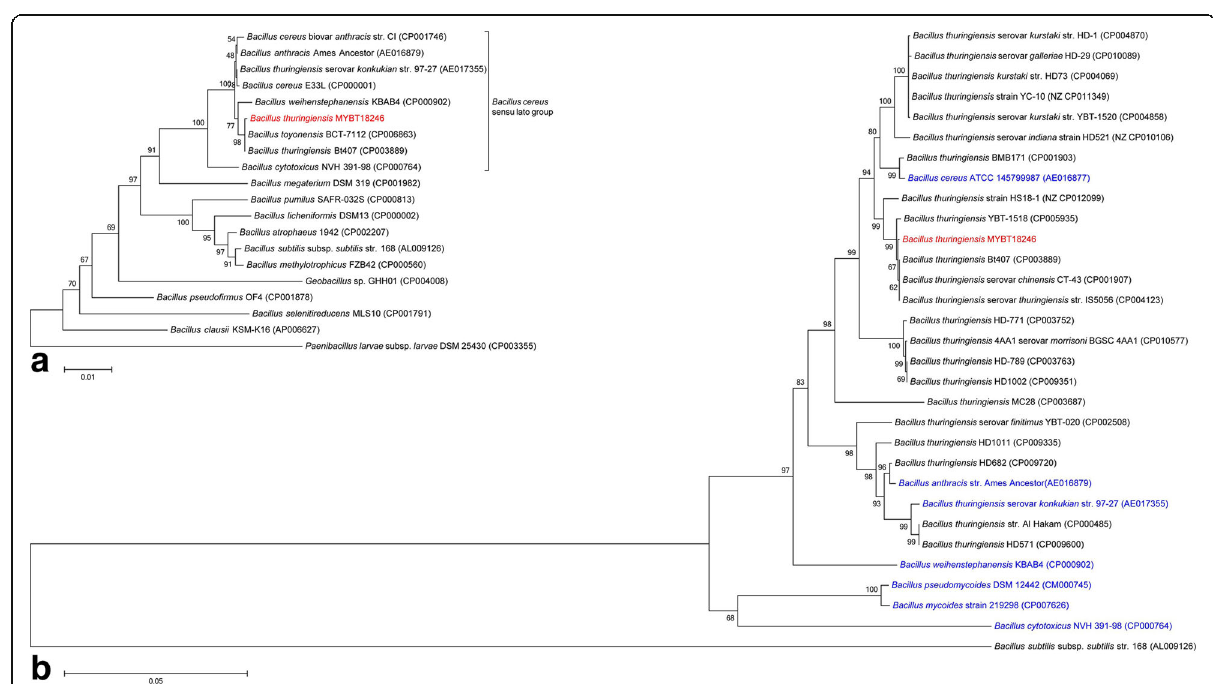
Fig. 2 Phylogenetic tree highlighting the taxonomic relation of B. thuringiensis MYBT18246 (red) based on a ) 16rDNA amplicon within the Bacillus clade b ) Multi-locus sequence typing within the Bacillus cereus sensu lato species group. GenBank accession numbers are given in parentheses. Comparison includes strains of the Bacilli clade or Bcsl group members (blue). Paenibacillus larvae subsp. larvae DSM 25430 or Bacillus subtilis subsp. subtilis str. 168 has been used as outlier to root the tree. Sequences were aligned using ClustalW 1.6 [91, 92]. The phylogenetic tree was constructed by using the Neighbor-Joining method [50] and evolutionary distances were computed by the Maximum Composite Likelihood method [51] within MEGA7.0 [52]. Numbers at the nodes are bootstrap values calculated from 1000